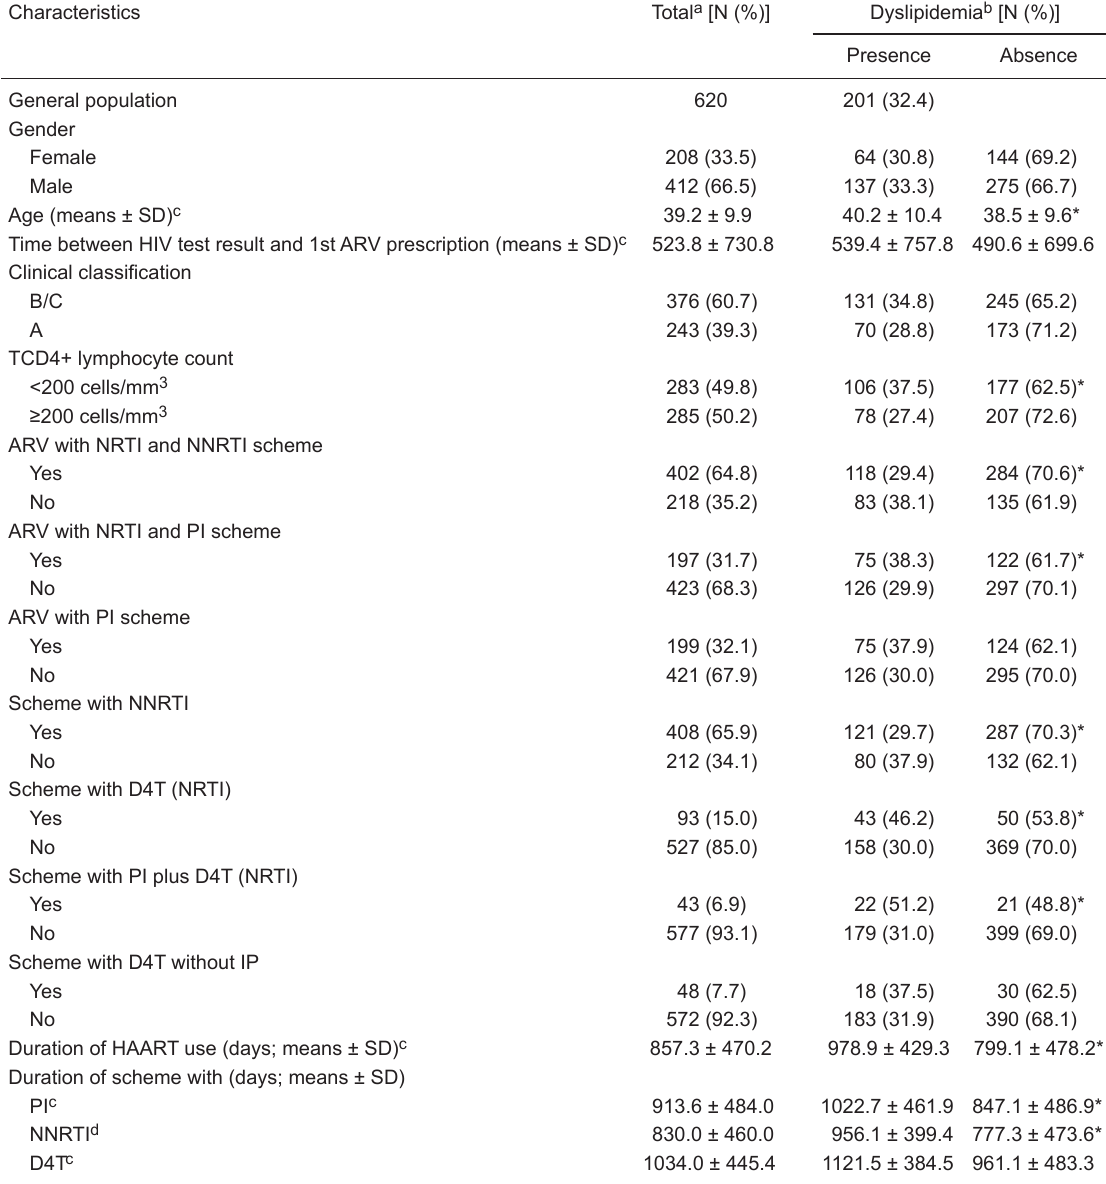
Table 3. Distribution of dyslipidemia in the patients